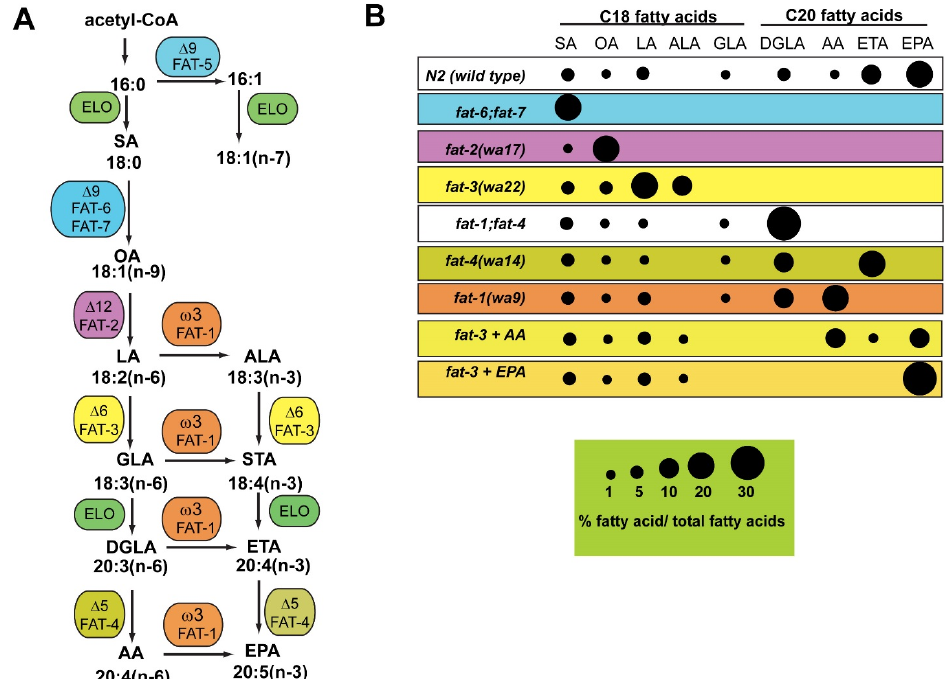
Figure 1. ( A ) Biosynthesis of omega ‐ 6 and omega ‐ 3 fatty acids in C. elegans . Unlike most other animals, C. elegans possesses ∆ 12 desaturase and ω 3 desaturase enzymes, and therefore does not require essential dietary fatty acids to synthesize a range of omega ‐ 6 and omega ‐ 3 fatty acids; ( B ) Mutant strains lacking functional desaturase enzymes are depleted in specific polyunsaturated fatty acids. The area of each circle represents the ratio of specific fatty acids relative to total fatty acid content. Data shown are representative examples of multiple GC/MS measurements. Abbreviations: ELO, elongase; SA, stearic acid; OA, oleic acid; LA, linoleic acid; ALA, alpha ‐ linolenic acid; GLA, gamma ‐ linolenic acid; STA, stearidonic acid; DGLA, dihommo gamma ‐ linolenic acid; ETA, eicosatrienoic acid; AA, arachidonic acid; EPA, eicosapentaenoic acid. Figure is modified from [23].